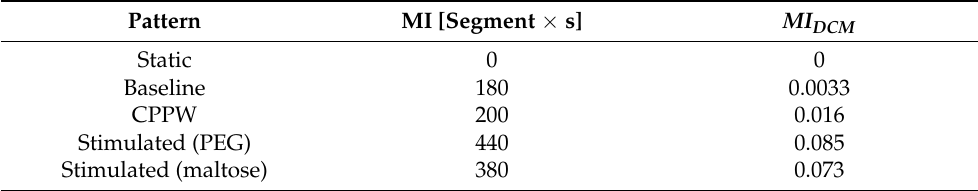
Table 3. Comparison of the existing motility index and the MI DCM from the motility patterns applied to the